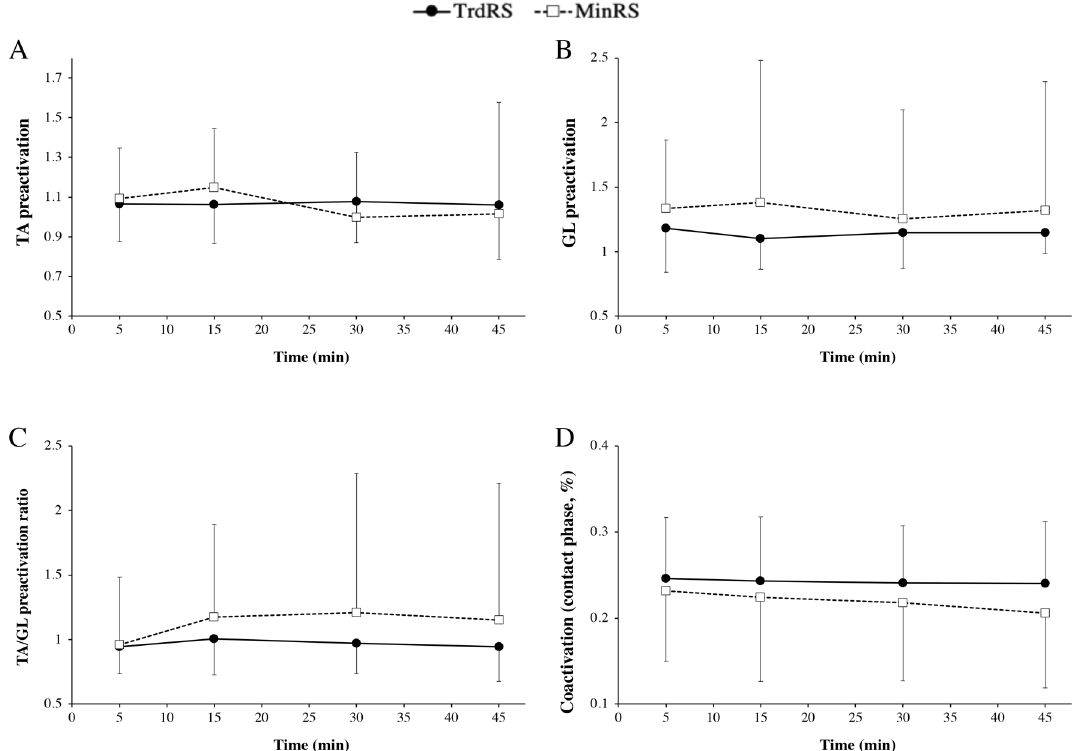
Figure 5. Tibialis anterior (TA) ( A ) and gastrocnemius lateralis (GL) ( B ) preactivation, TA/GL preactivation ratio ( C ) and TA and GL coactivation during the contact phase ( D ) versus time during the two experimental conditions [traditional cushioned (TrdRS) and minimalist (MinRS) running shoes]. Values are mean ± SD (n =